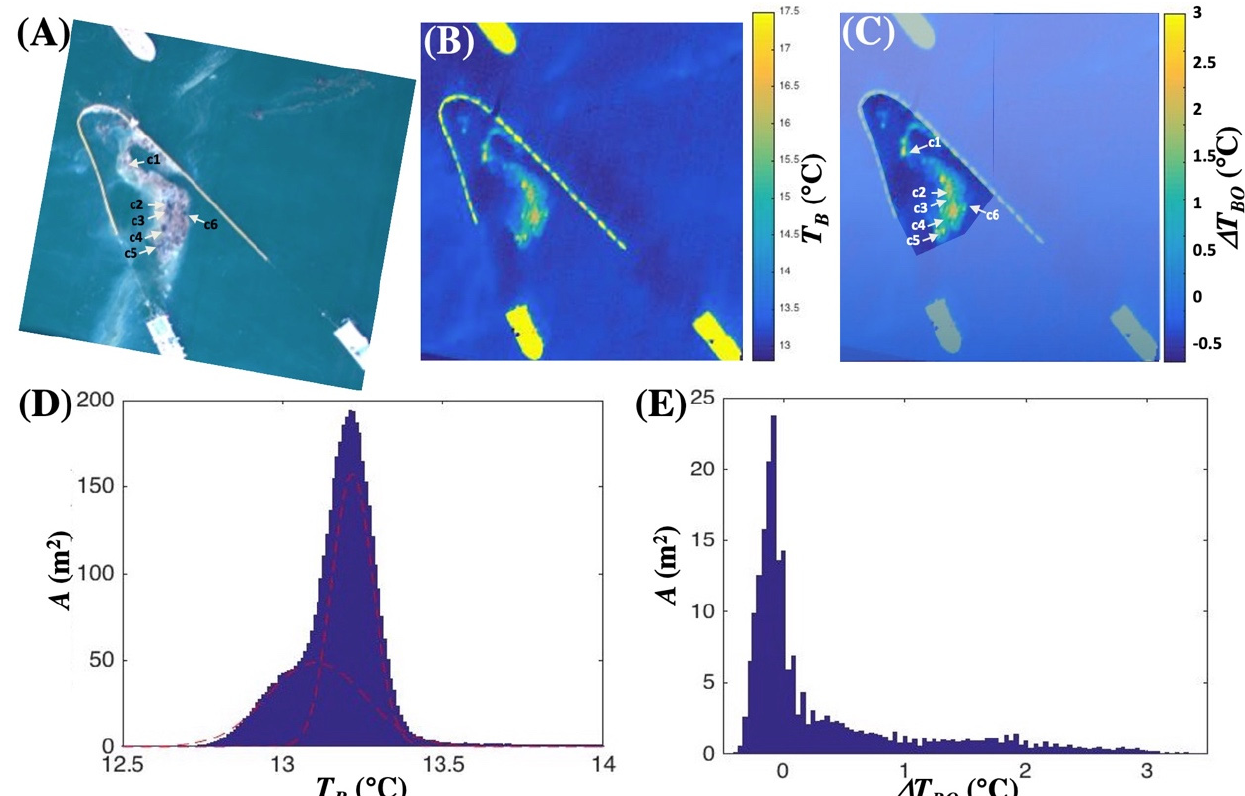
Figure 2. Oil collection #10 for ( A ) Visible, black oil identified. ( B ) Brightness temperature, T B , image. ( C ) Oil brightness temperature contrast ( Δ T BO ) image, the area outside boom dimmed. Visible black oil locations labeled. ( D ) Area ( A ) histogram of T B (number × pixel area) and Gaussian curve fit to model water scene elements. ( E ) Area histogram of Δ T BO for the boom image subset shown in ( C ). Data key on the figure. Imagery acquired 23 May 2016.